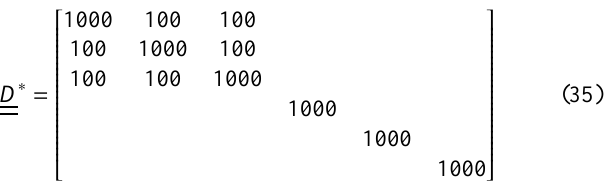
(solid line), κ ∗ 1 2